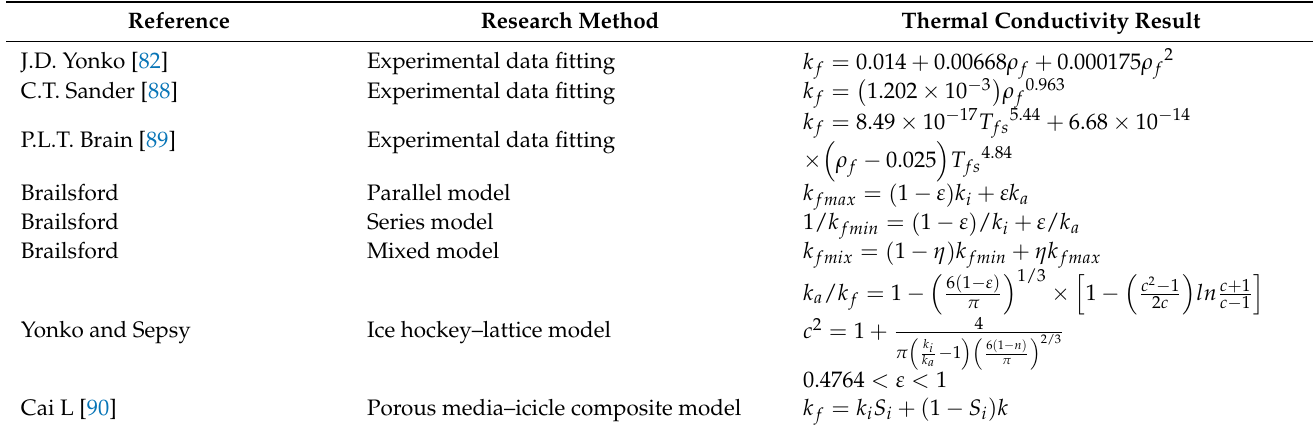
Table 4. Thermal conductivity of frost